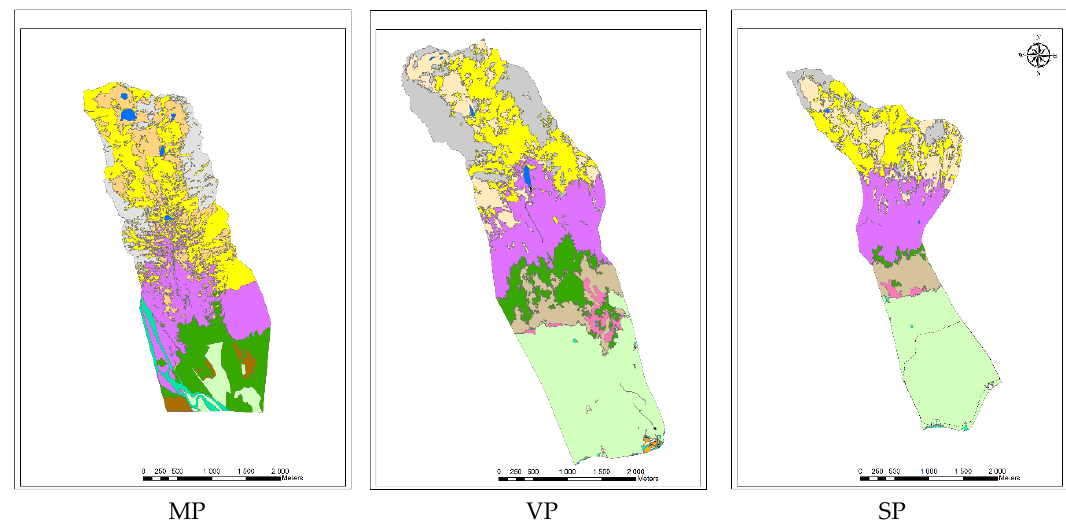
MP VP SP Figure 1. Ecosystem types (legend in Table 1) in the carbon study part of the catchments; MP (area to stream gage 83 km 2 , mean altitude 991 m a.s.l., mean slope 9.2°), VP (area 58 km 2 , mean altitude 1094 Table 1. Total catchment area (km 2 ), portion of deforestation in 2004 and carbon study areas (ha) with proportion (%) of ecosystem types in the mountain parts of study catchments in 2015; MP — the